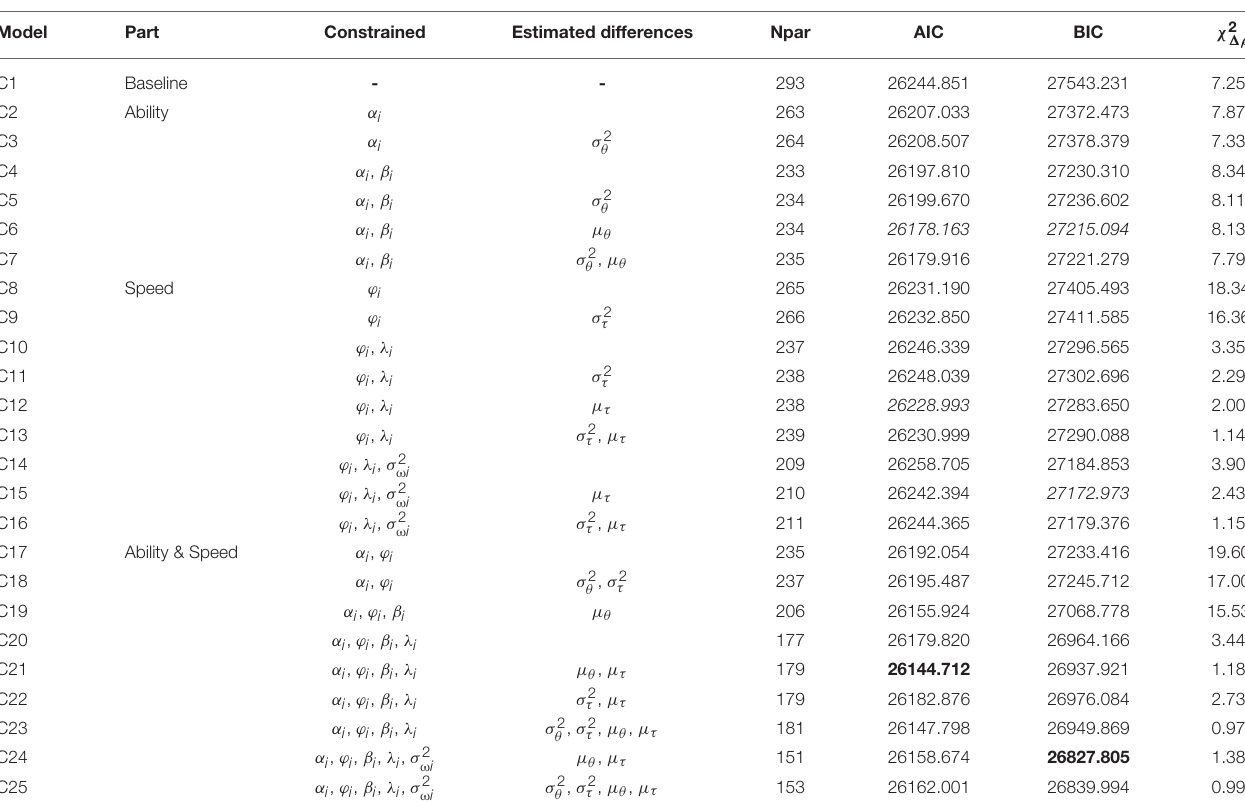
TABLE 2 | Measurement invariance of the B-GLIRT model with linear interaction term in the cross-relation function with respect to gender for data from computer-based assessment.